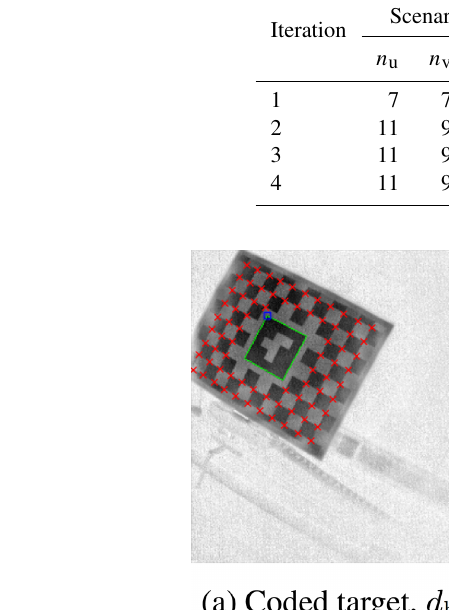
Figure 7. Smallest border distance at which features are